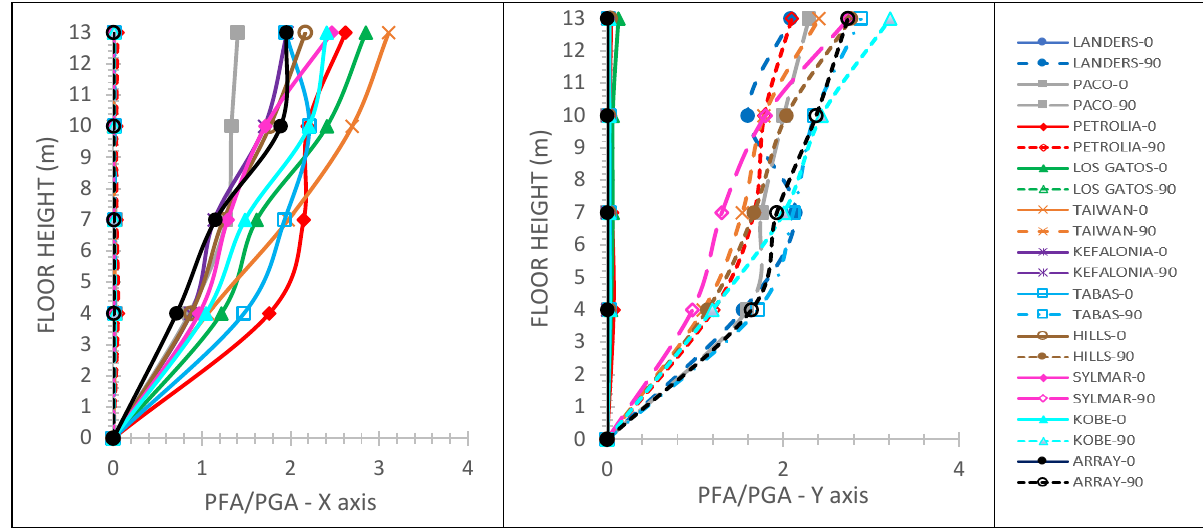
Figure 12. RIDR along X ( left ) and Y ( right ) horizontal directions of the four-story mixed building, considering the fixed- pinned connection of the steel structure to the r/c one.